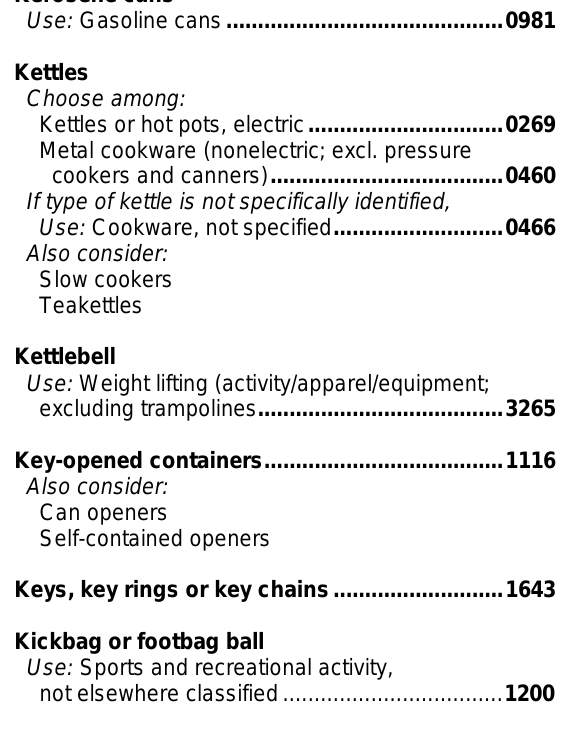
Kitchens (fire) Use: General home or